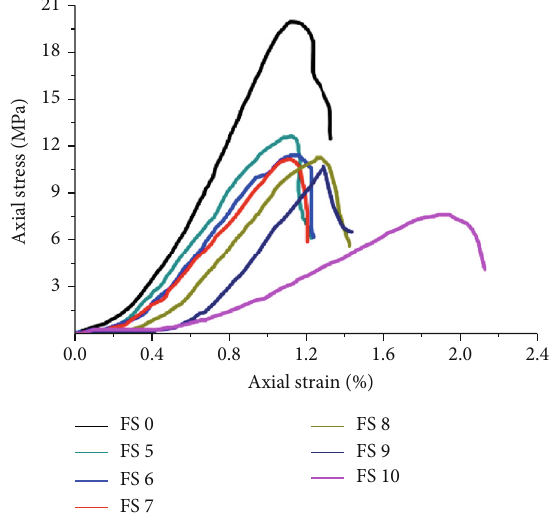
Figure 22: Curve of water absorption quantity of the siltstone samples.